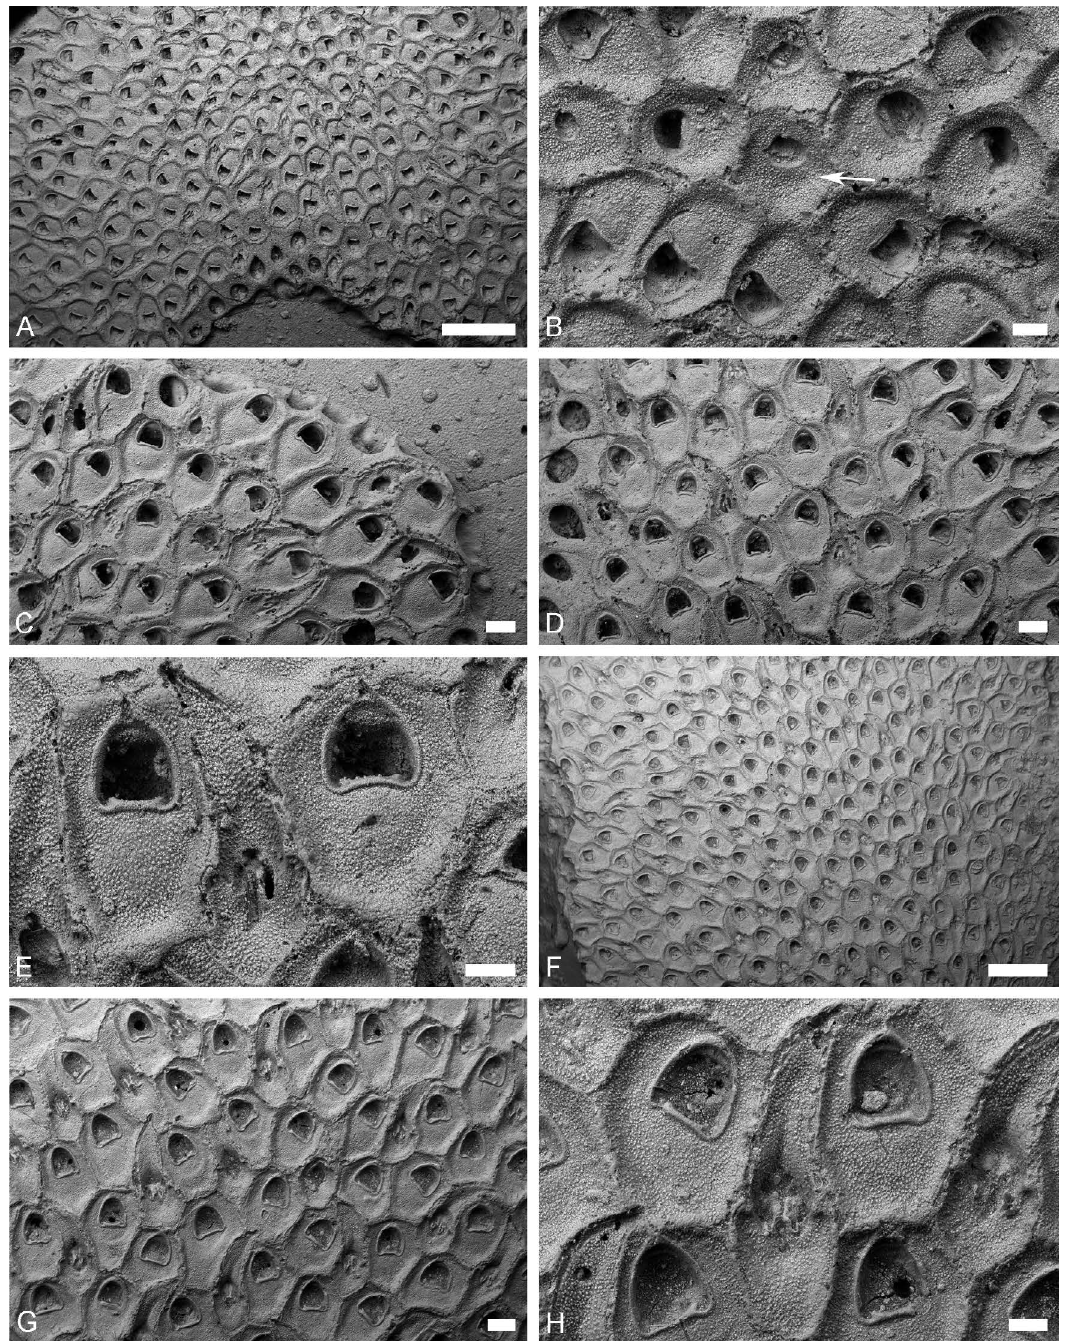
Fig. 8. Rhagasostoma angliae (Brydone, 1936). A–E . Lectotype, SM B36877, Middle Campanian ( Belemnitella mucronata Zone) of Hartford, Norwich, Norfolk, England, UK. A . Overview of encrusting colony. B . Early astogeny, ancestrula arrowed. C . Growing edge, avicularia and some autozooids with peripheral caverns surrounding the cryptocyst. D . Autozooids and avicularia. E . Avicularium with peripheral caverns surrounding the cryptocyst and non-ovicellate autozooids. F–H . Paralectotype, SM B36879, early Maastrichtian ( Ostrea lunata Zone) of Trimingham, Norfolk, England, UK. F . Erect bifoliate colony. G . Non-ovicellate autozooids and avicularia. H . Avicularia and non-ovicellate autozooids. Scale bars: A, F = 1 mm; B, E, H = 100 µm; C–D, G = 200